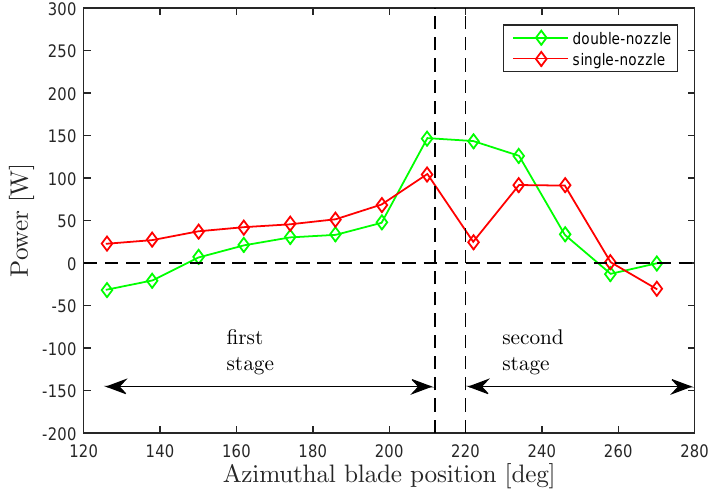
Figure 9. Comparison of stage performances for the single- and double-nozzle turbines [ Q max = 46 lps per nozzle, H = 1.33 m and ω max = 199 RPM]. The negative power indicates that those blades lose power to the